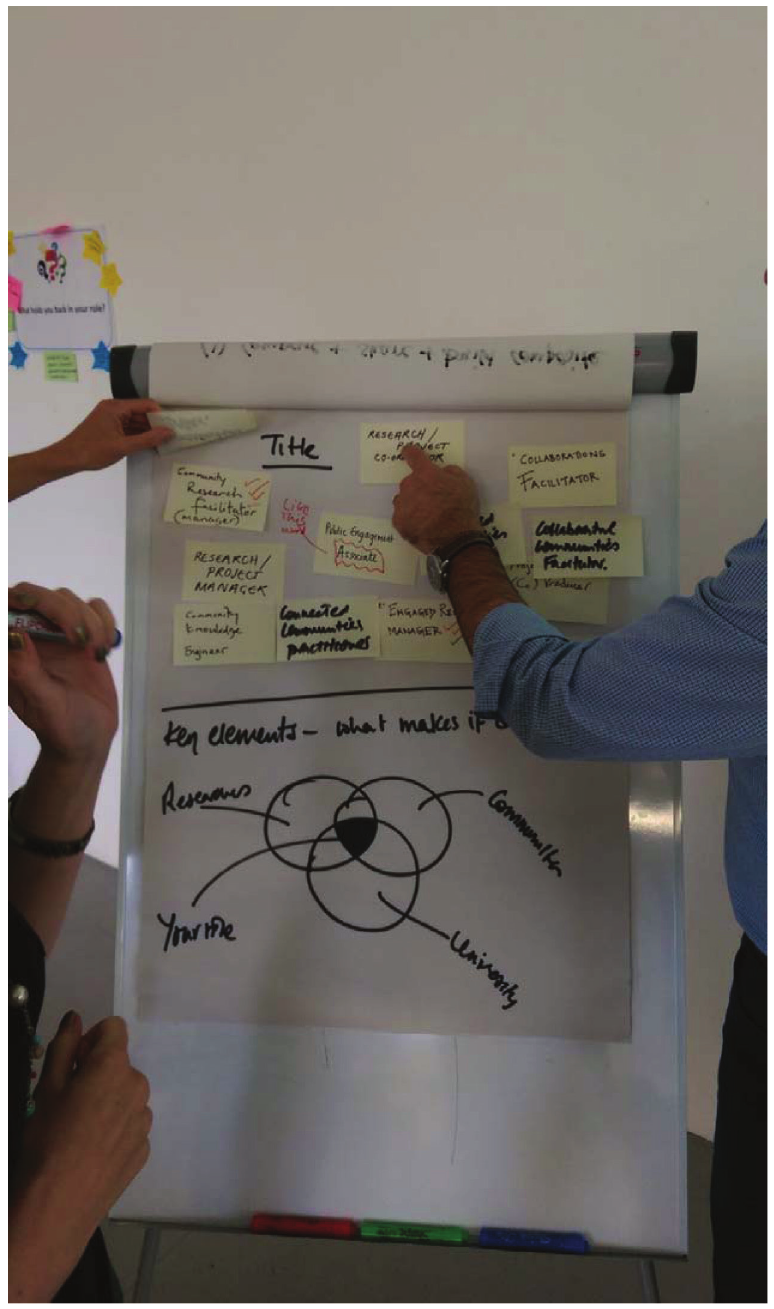
Figure 1: Workshop participants collaborating on the